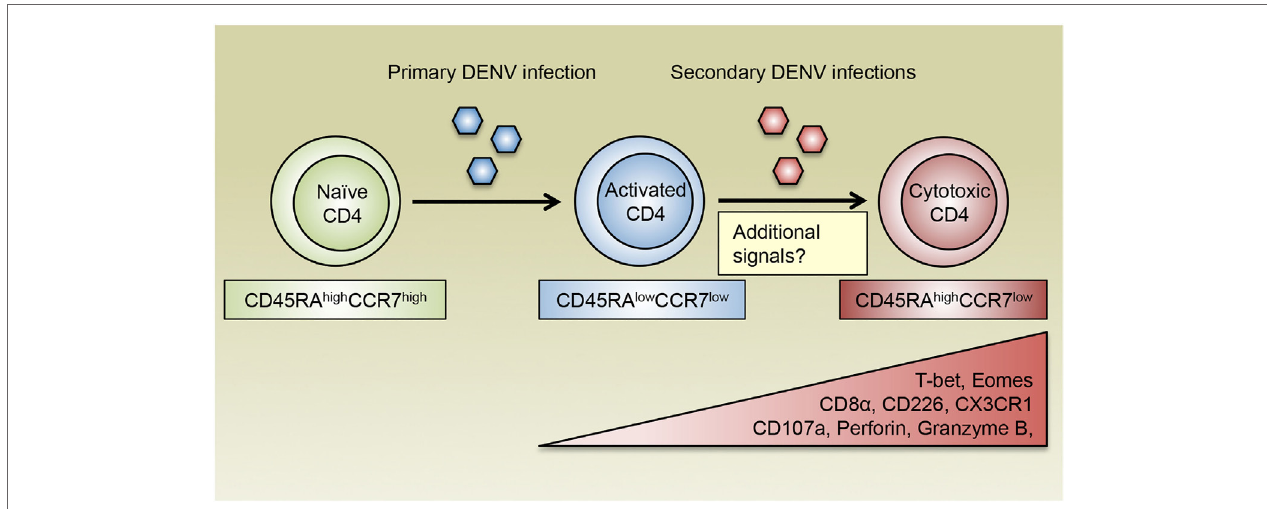
FiGURe 2 | The generation of cytotoxic CD4 T cells following DeNv infections . DENV-specific naïve CD4 T cells are activated during primary DENV infection and acquire an effector phenotype and the ability to produce inflammatory cytokines such as IFN- γ . Following reexposure to secondary heterologous infections, DENV-specific CD4 T cells receive repeated antigenic signals and differentiate into cytotoxic CD4 T cells, which display a CD45RA high CCR7 low Temra phenotype and are characterized by their expression of the chemokine receptor CX3CR1. Cytotoxic CD4 T cells also upregulate the expression of CD8 α and CD226, as well as the transcription factors T-bet and Eomes, which may cooperate with additional transcription regulators to induce the production of cytotoxic molecules such as CD107a, perforin, and granzyme B. In addition to recurring antigens, costimulatory molecules, cytokines, and other environmental cues are all likely to modulate the differentiation of cytotoxic CD4 T